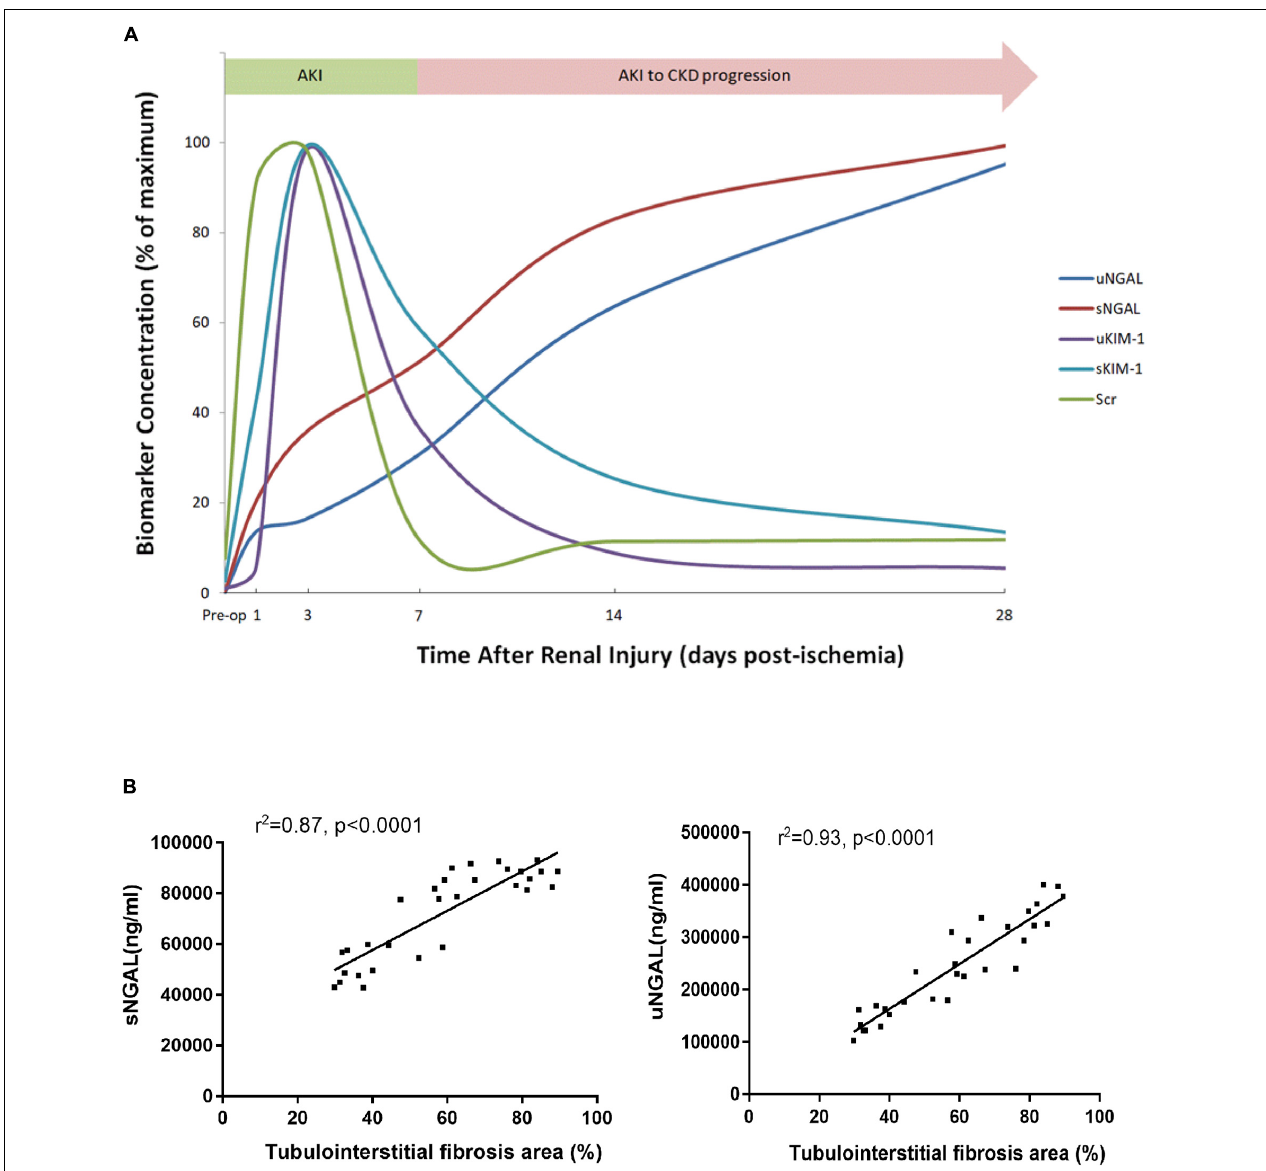
FIGURE 9 | NGAL was better associated with AKI-to-CKD progression. (A) The time course of changes in Scr levels and biomarker concentration after 45 min of UIRI. To create this plot, the level at the time point with the highest mean value was set to 100%, and the levels at all other time points were converted to a percentage of this maximum. (B) Correlations were analyzed between sNGAL and the extent of tubulointerstitial fibrosis ( r = 0.87, P < 0.0001) and uNGAL and the extent of tubulointerstitial fibrosis ( r = 0.93, P < 0.0001). sNGAL: serum NGAL, uNGAL: urinary